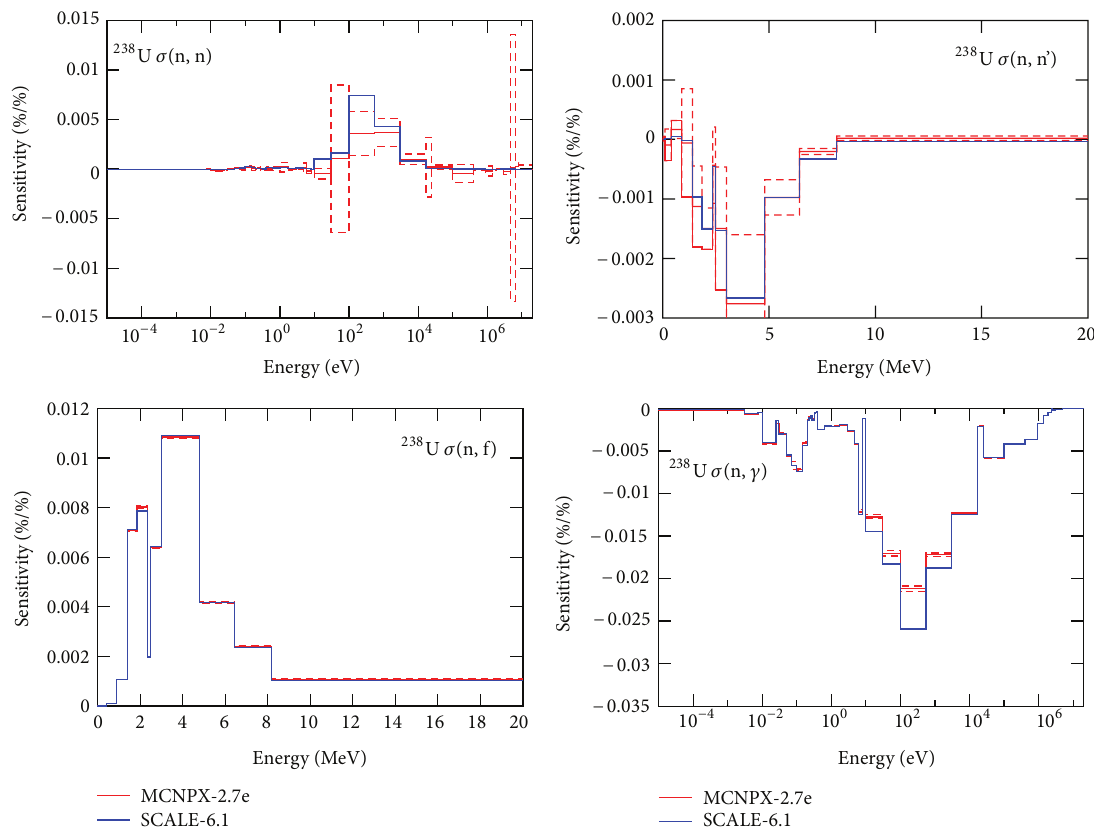
Figure 3: Sensitivity profiles of 238 U reaction cross sections calculated by MCNPX-2.7e and SCALE-6.1 for rodded case at HZP.